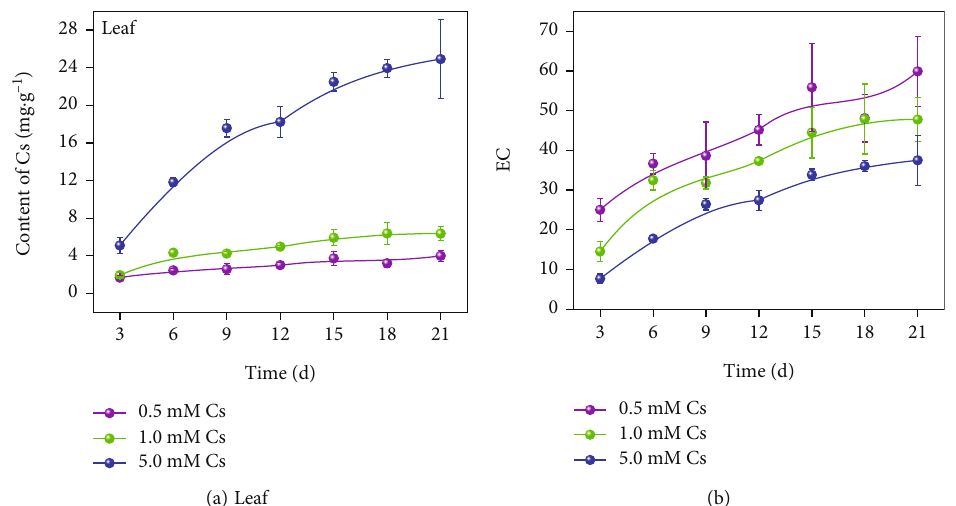
Figure 2: Analysis of the uptake process of cesium in lettuce leaves. (a) was the uptake kinetics of cesium. (b) was the enrichment coe ffi cient of